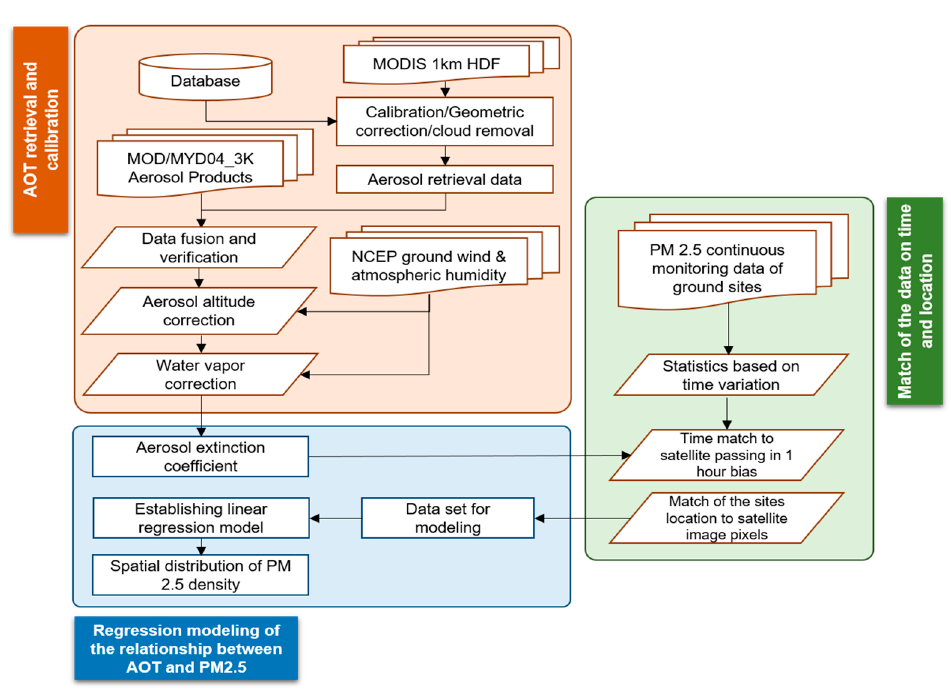
Figure 2. Process of modelling the relationship between aerosol optical thickness (AOT) and PM 2.5 .